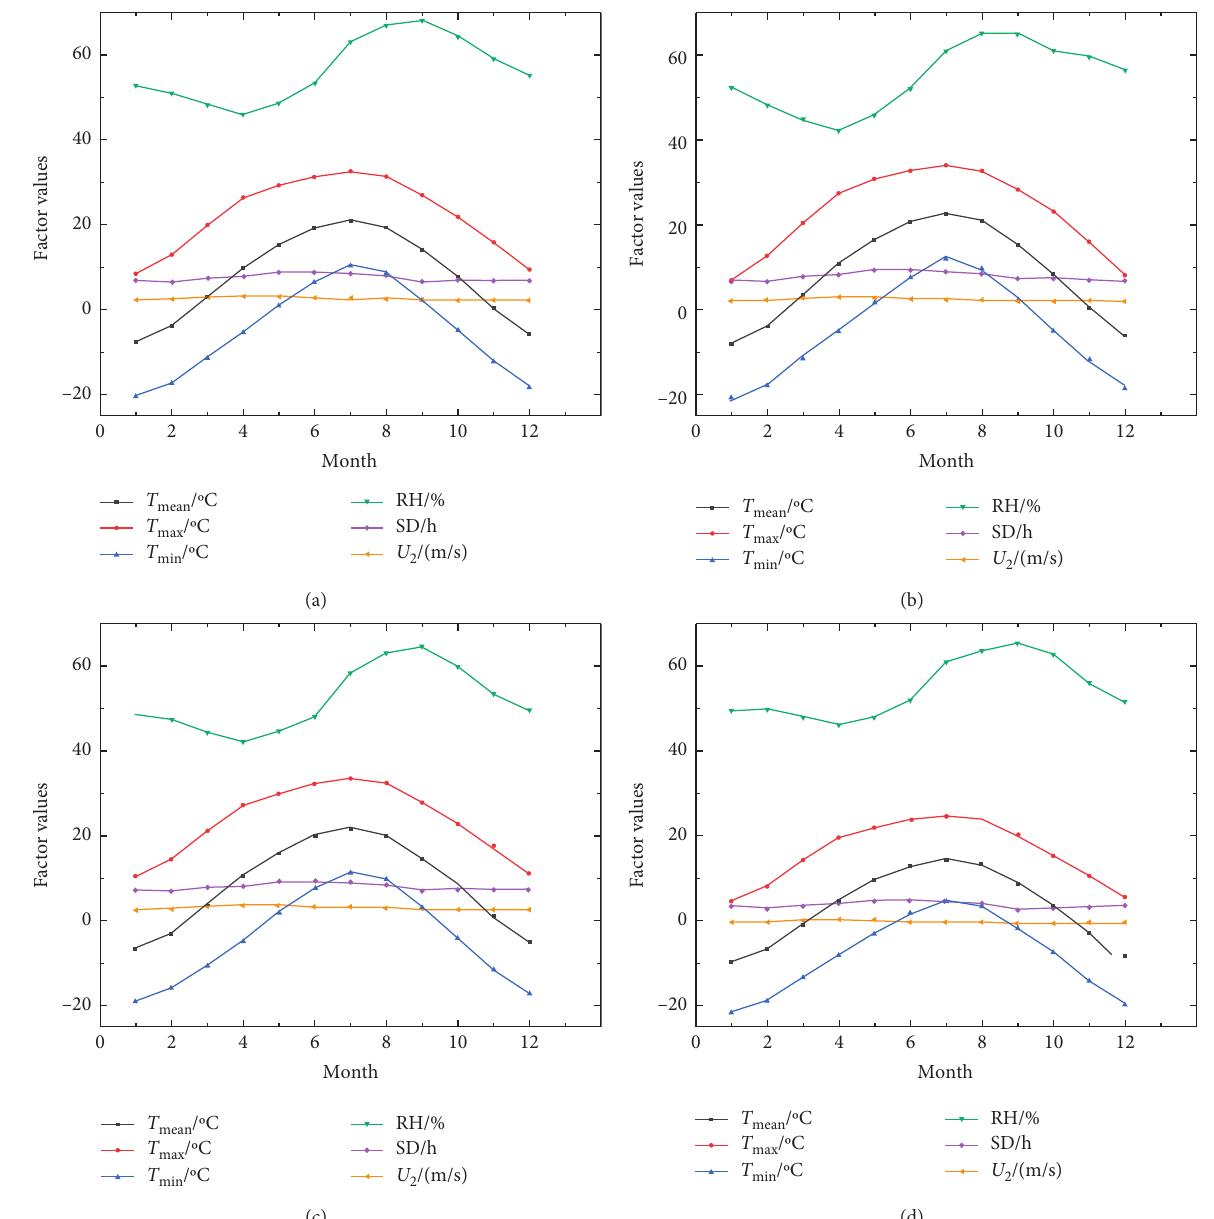
Figure 4: Monthly variations in spatially averaged values of climate data (average temperature ( T minimum temperature ( T min ), relative humidity (RH), sunshine duration (SD), and wind speed ( U 2 ) from 1957 to 2018 in different climate zones): (a) Ningxia (NX); (b) Northern Yellow River irrigation area (NYR); (c) Central Arid Zone (CAZ); (d) Southern Mountain Area